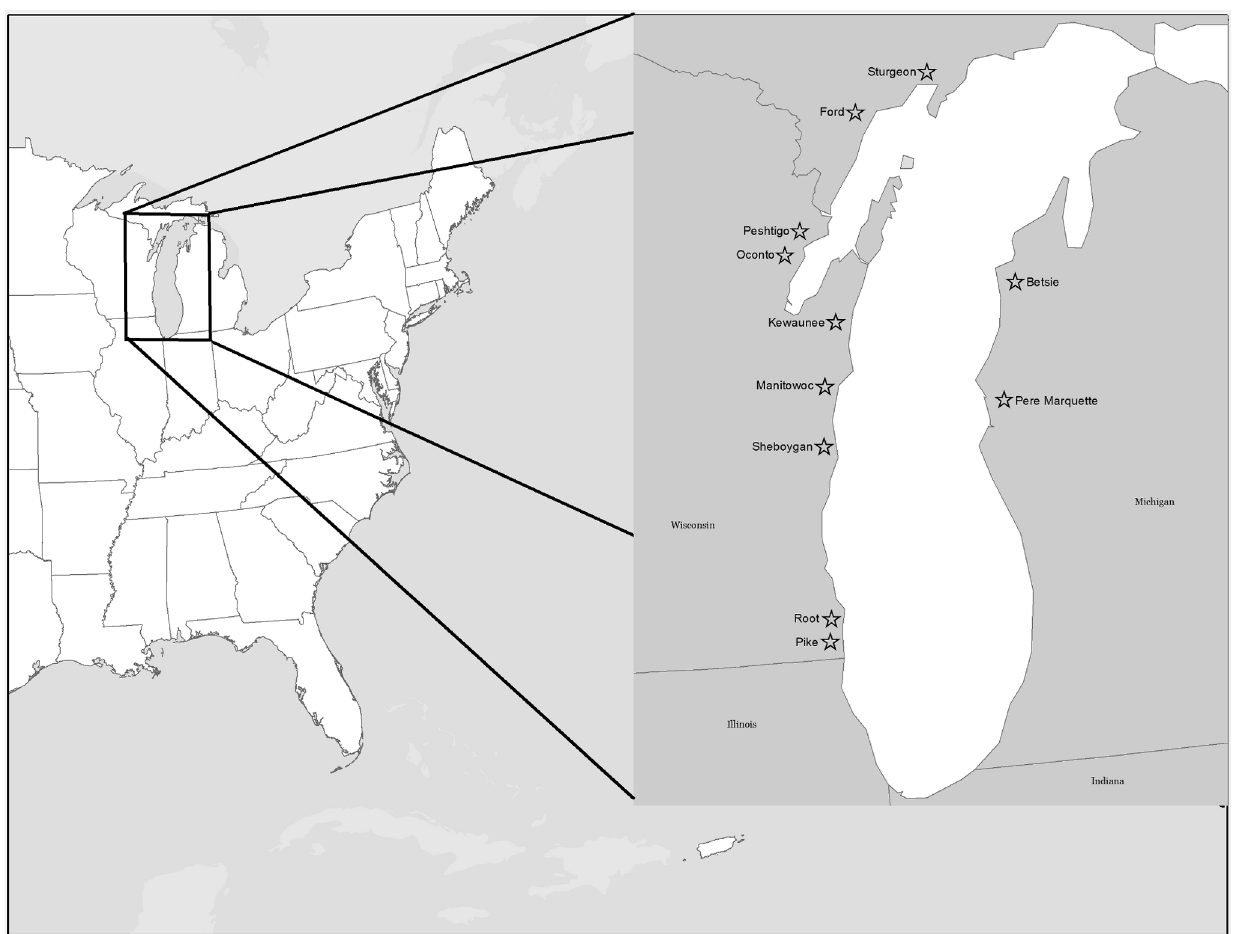
Figure 2. Location of rivermouth systems sampled during this study. More detailed geographic information is available in Appendix S1.